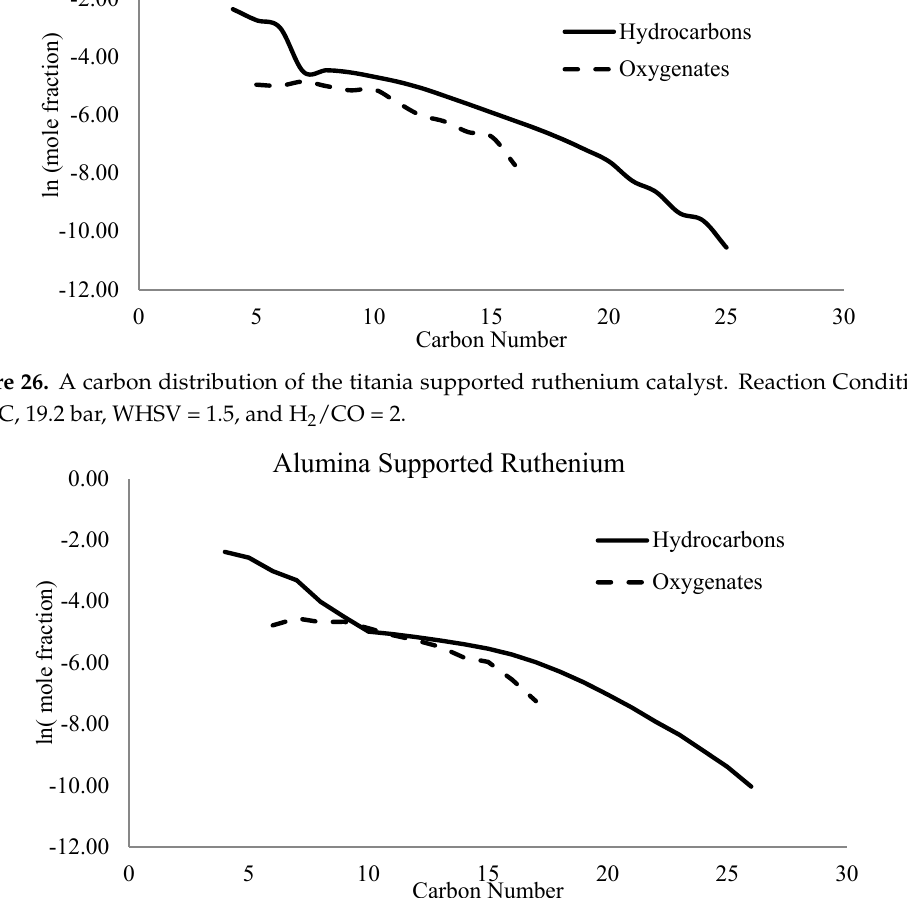
Figure 27. A carbon distribution of the alumina supported ruthenium catalyst. Reaction Conditions: 220 °C, 19.2 bar, WHSV = 3, and H 2 /CO = 2.